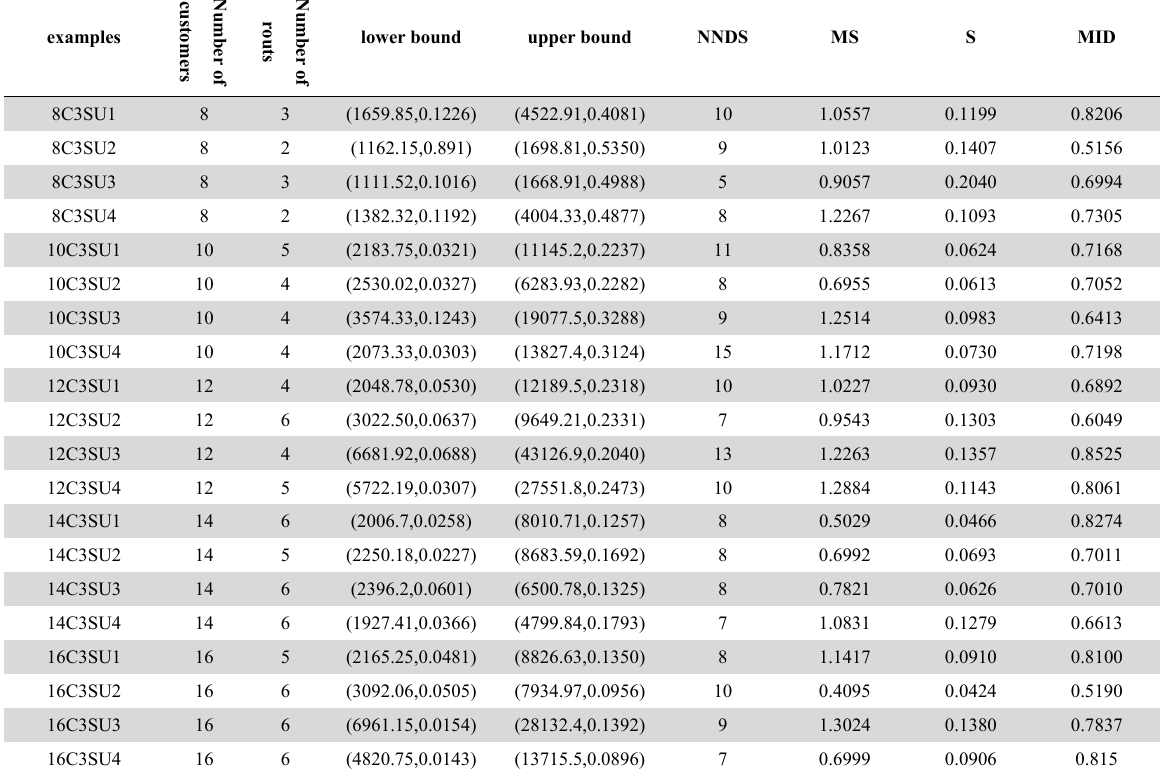
Table 3 Results and metrics Values of MOSA